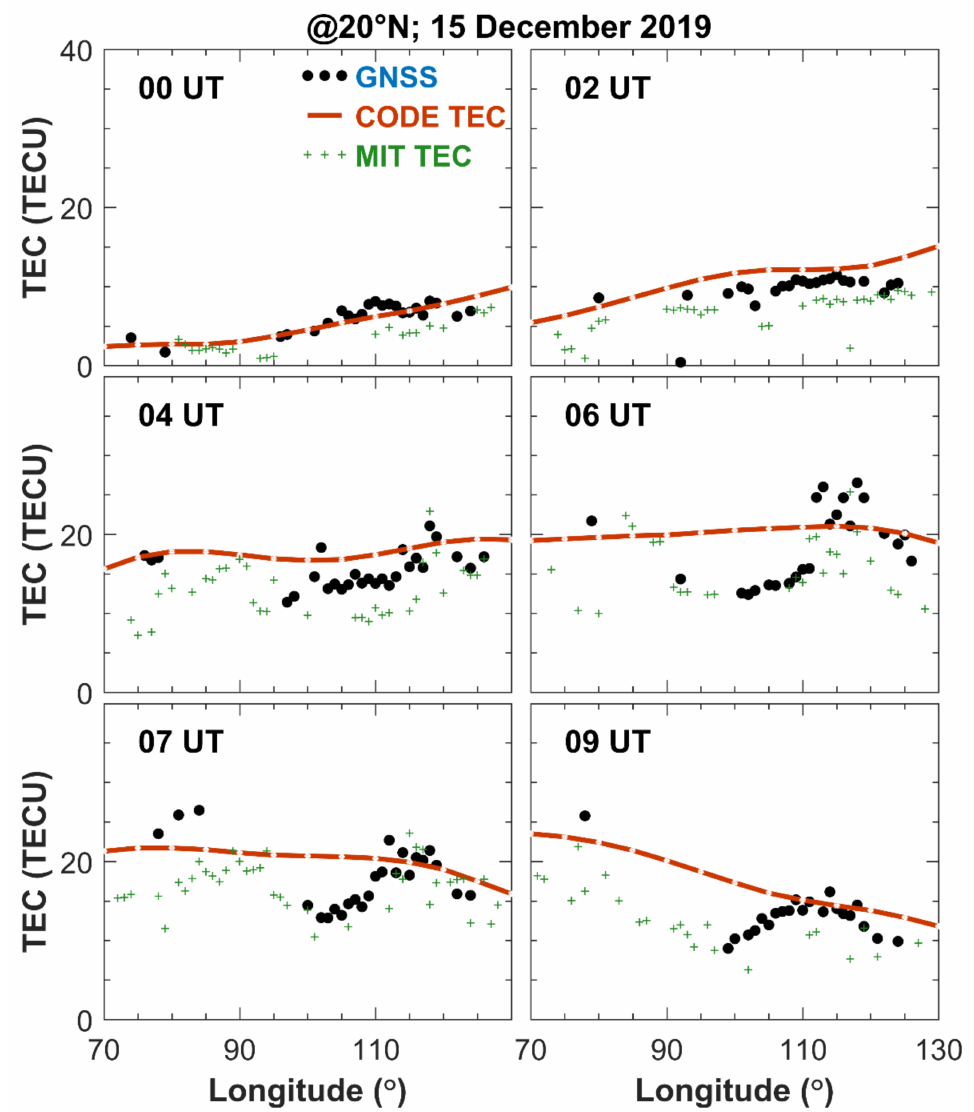
Figure 12. Snapshots of the longitudinal variation of the TEC from the network of GNSS receivers, CODE GIM, and MIT TEC products on 15 December 2019. The black dots are the regional GNSS TEC observations, the green pluses are for that of MIT TEC, and the brown curves for the CODE